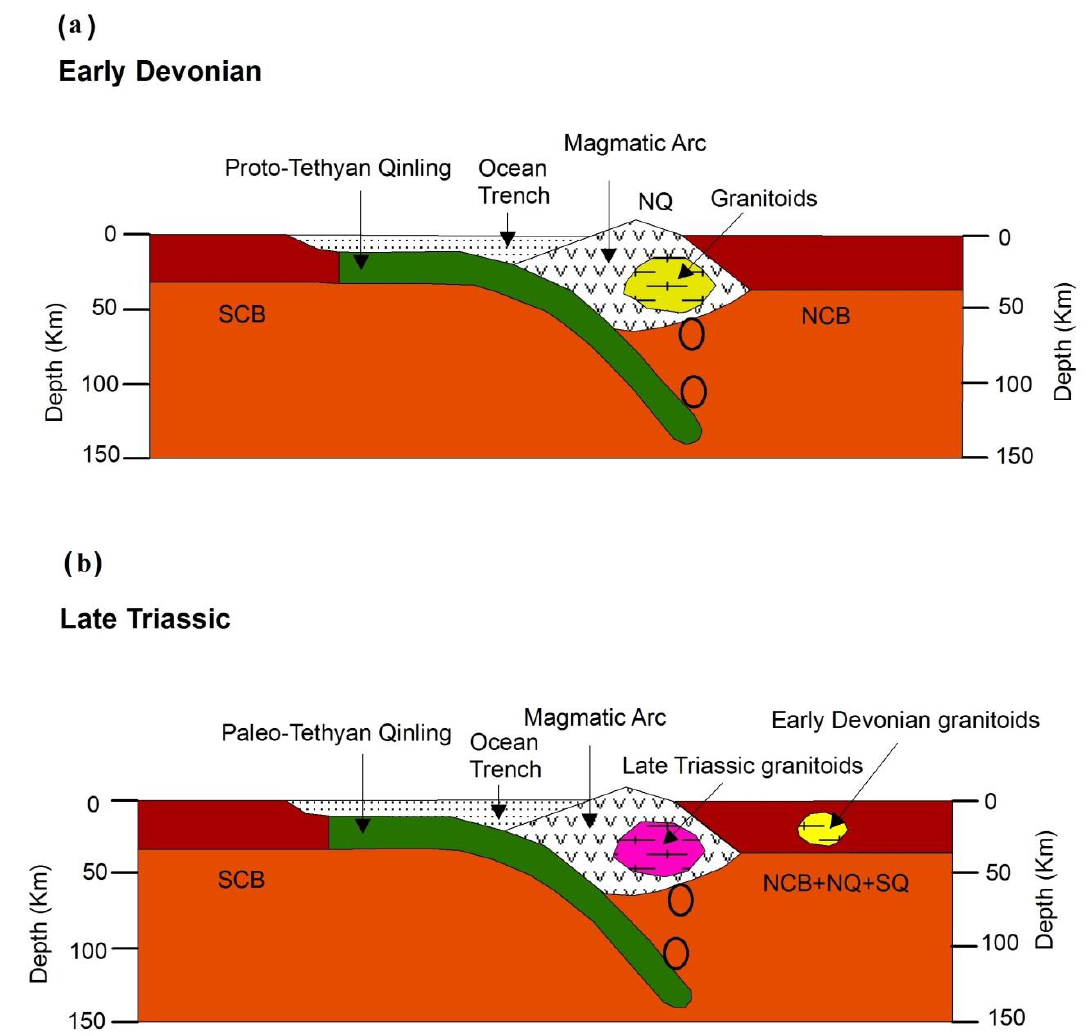
Figure 11. A schematic model that describes the subduction of the Proto-Tethyan Ocean ( a ) and Paleo-Tethyan ocean ( b ) that produced the granitoids of the Tainshui area. Abbreviations are; NCB = North China block; SCB = South China block; NQ = North Qinling orogen; SQ = South Qinling orogen.